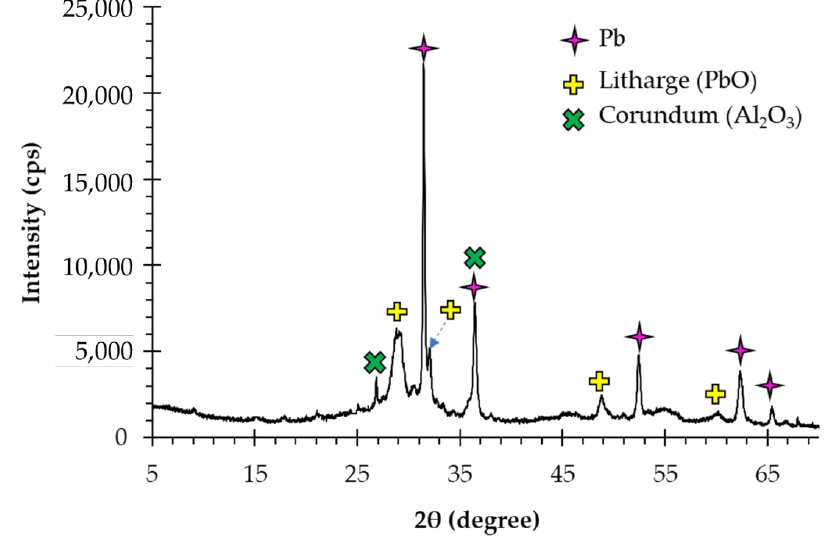
Figure 6. XRD pattern of the +150 µm fraction obtained after sieving the leaching residue in the experiments with ZVAl. experiments with